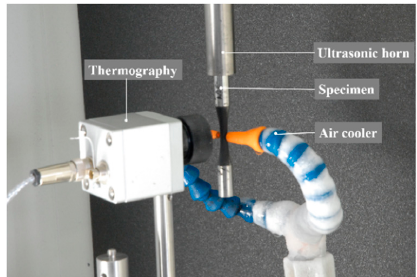
Figure 3. A photograph of the ultrasonic fatigue test setup.